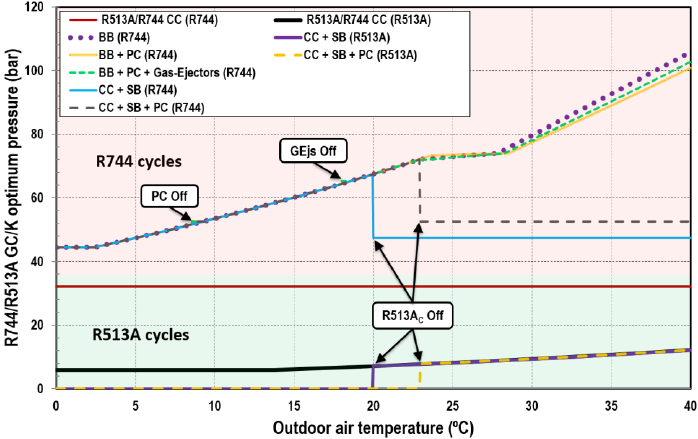
Table 4. Maximum optimum pressures.